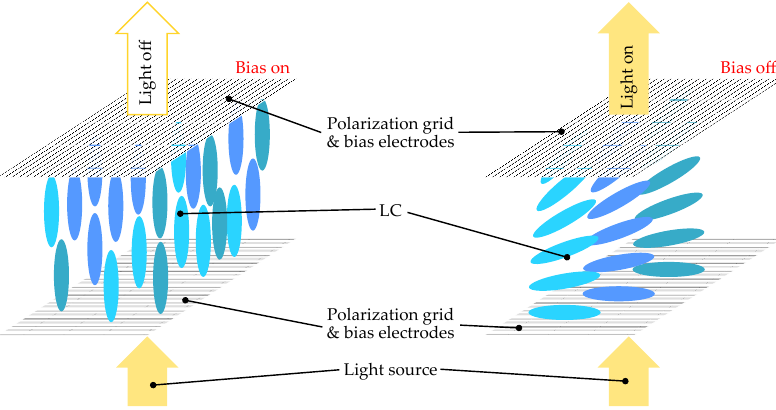
Figure 1. Working principle of a TN-cell used in LCDs. (Right) the unbiased LC rotates polarization by 90 ◦ . The light can pass two twisted polarization grids and the pixel is on. When the LC is biased (Left), the polarization of light is not rotated. Hence, the pixel is off as the light cannot pass the second polarization grid.